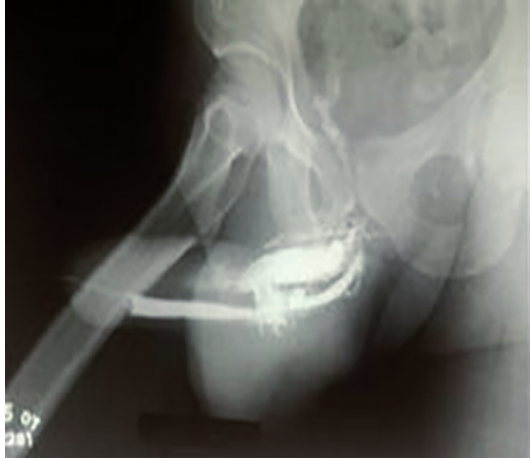
Figure 3 - The figure shows a uretrocistography of a patient with penile fracture and urethral